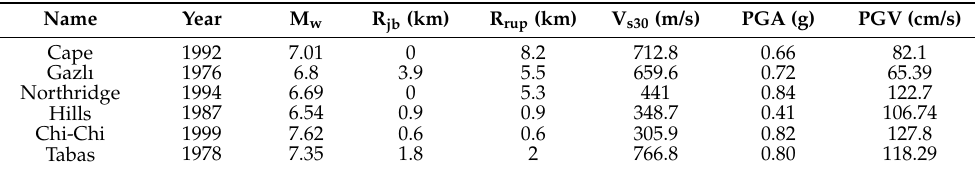
Table 1. Properties of the ground motion